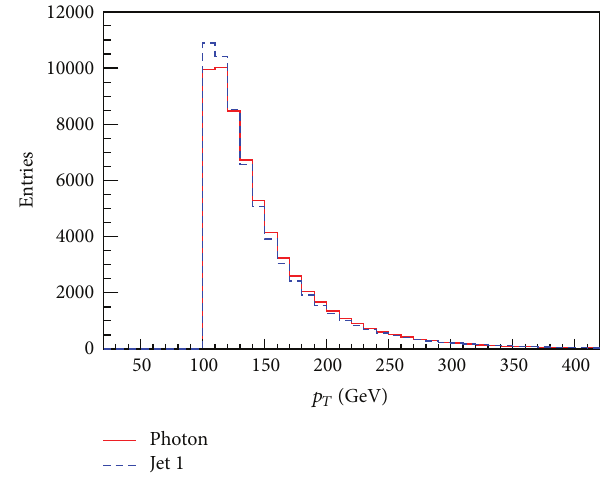
Figure 18: Transverse momentum distributions of leading jet and photon ( 𝑗𝛾 production) for background at the given conditions mentioned in the text.